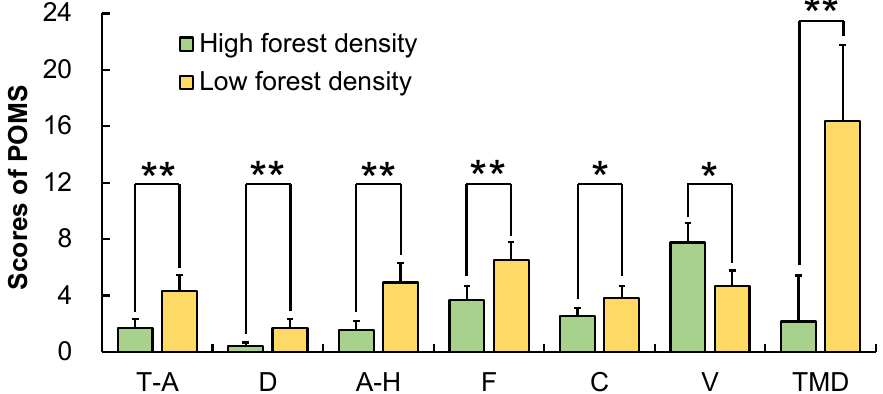
Figure 10. The average pulse rate of blood pressure between high forest density and low forest density. ( A ) Changes in the four periods of average pulse rate frequency. N = 17, mean ± standard error. ( B ) Effect on pulse rate frequency in “after exercise”. N = 17, mean ± standard error. * p < 0.05 using the paired t ‐ test.